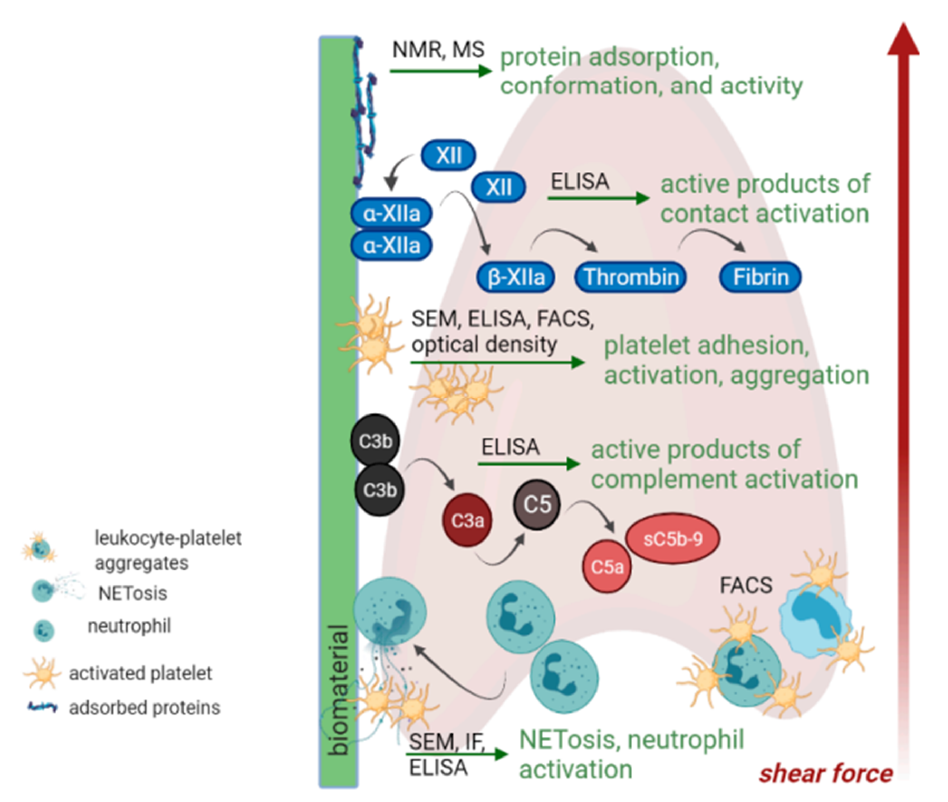
Figure 3. In vitro tests for blood compatibility. Reproduced from [38] Creative Commons CC-BY license. Abbreviations: Nuclear Magnetic Resonance (NMR), Mass Spectrometry (MS), Enzyme- linked immunosorbent assay (ELISA), Fluorescence activated cell sorting (FACS), Scanning Electron Microscopy (SEM), Immunofluorescence (IF).